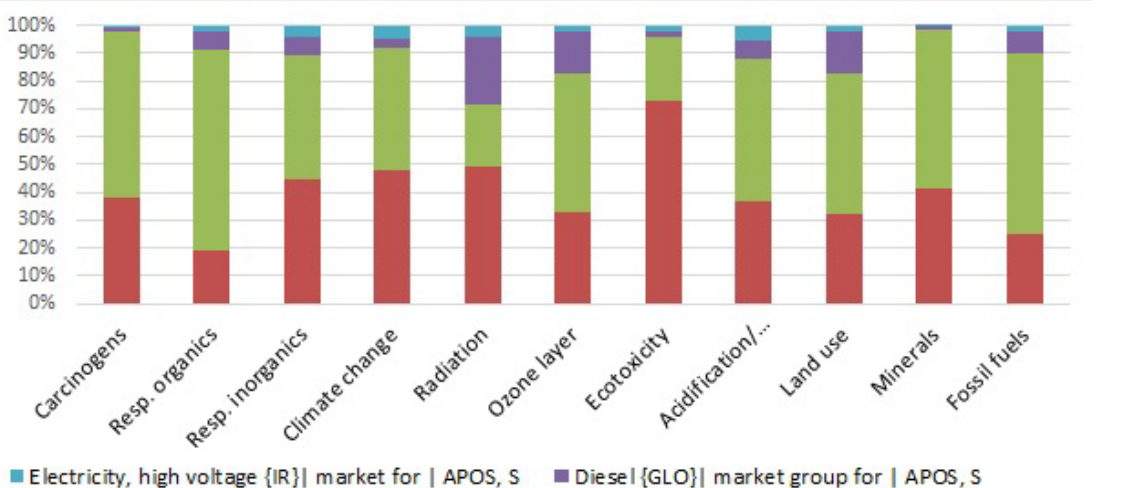
Figure 2. Results of applying the coefficients of determining the characteristics of the Eco-indicator 99 method in calculating the impacts